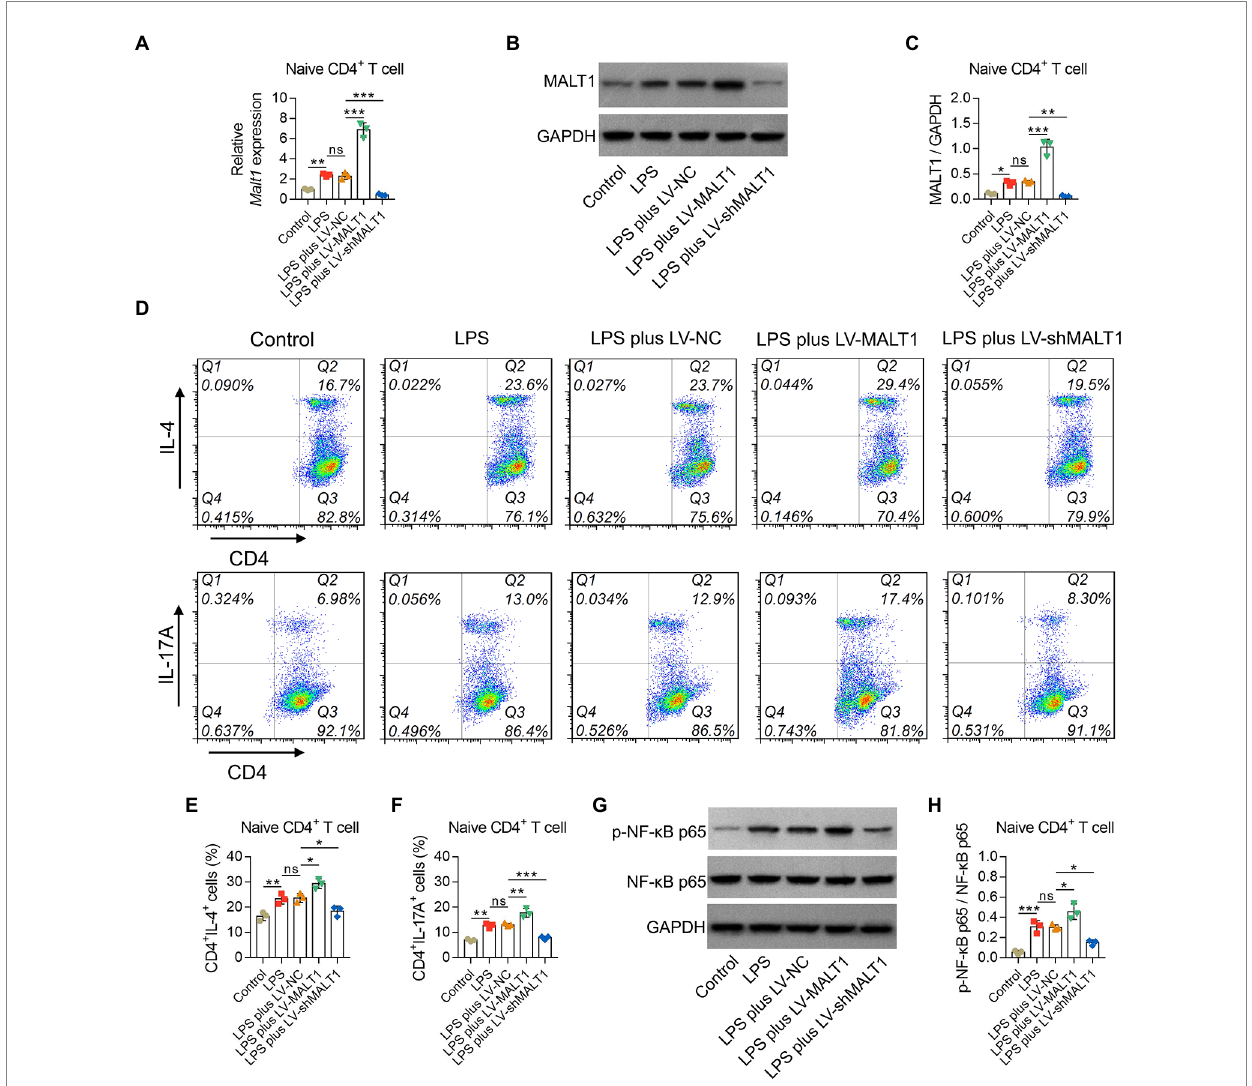
FIGURE 9 Effect of MALT1 on the polarization of LPS-treated naïve CD4 + T cells. Comparison of MALT1 mRNA levels (A) and protein levels ( B , C ) among Control, LPS, LPS plus LV-NC, LPS plus LV-MALT1, and LPS plus LV-shMALT1 groups. Flow cytometry analysis of Th2 and Th17 cells among Control, LPS, LPS plus LV-NC, LPS plus LV-MALT1, and LPS plus LV-shMALT1 groups ( D ). Comparison of Th2 (E) and Th17 (F) cell proportions among Control, LPS, LPS plus LV-NC, LPS plus LV-MALT1, and LPS plus LV-shMALT1 groups. Western blot detection of p-NF- κ B p65 (G) and comparison of the relative protein level of p-NF- κ B p65 (H) among Control, LPS, LPS plus LV-NC, LPS plus LV-MALT1, and LPS plus LV-shMALT1 groups. n = 3 in each group. One-way ANOVA plus Tukey’s post hoc test was applied. Ns, not significant; * p < 0.05; ** p < 0.01; *** p <